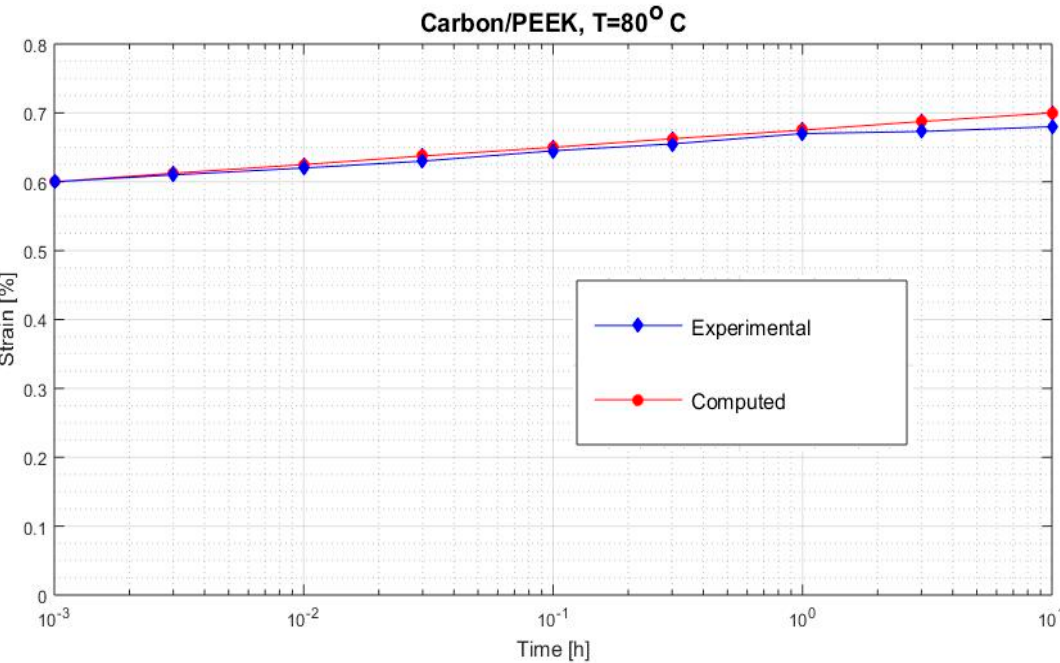
= σ 36 MPa at 80 °C). 22